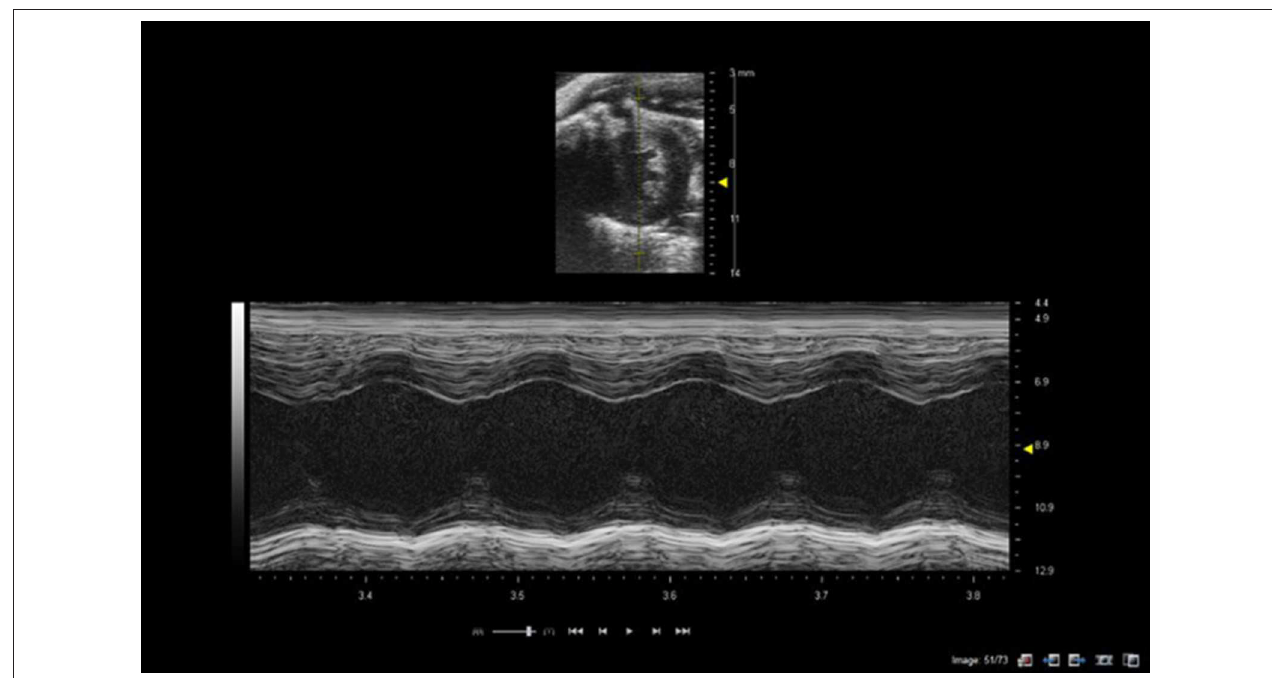
FIGURE 2 | M-mode of mouse heart showing short-axis B-mode image in top half of image with M-mode line selected (yellow line in image). Lower image shows M-mode trace through the left ventricle at level of papillary muscles. Images acquired using a 40 MHz probe focussed at 9mm depth.